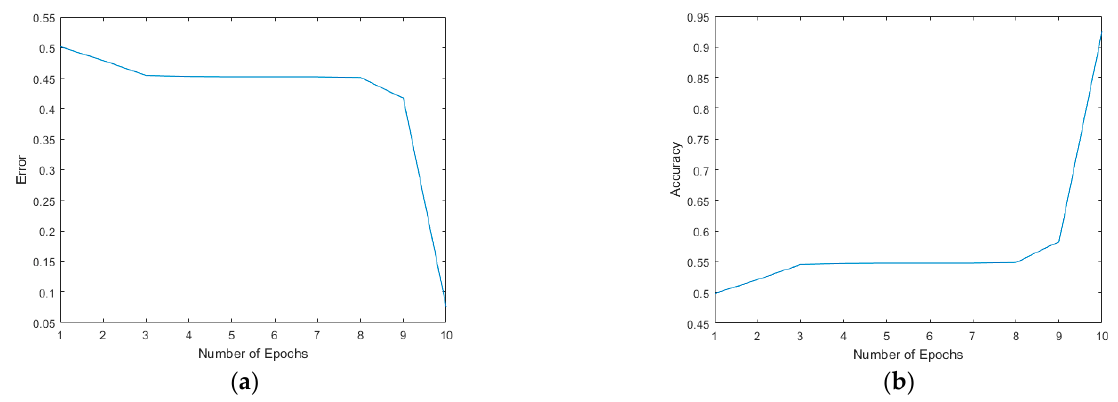
Figure 13. Training, testing error and accuracy of the proposed architecture. ( a ) The training error result. ( b ) The training accuracy.